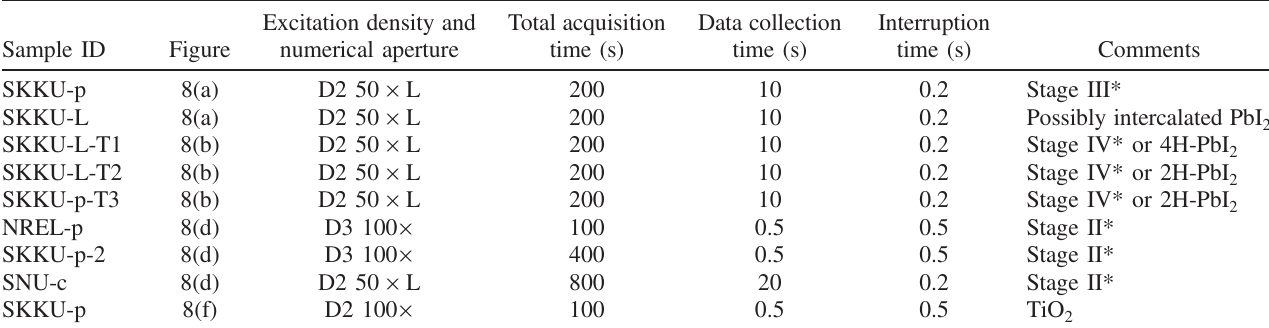
TABLE IV. Summary of Raman data in Fig. 8. The asterisk indicates a light-induced degradation state.